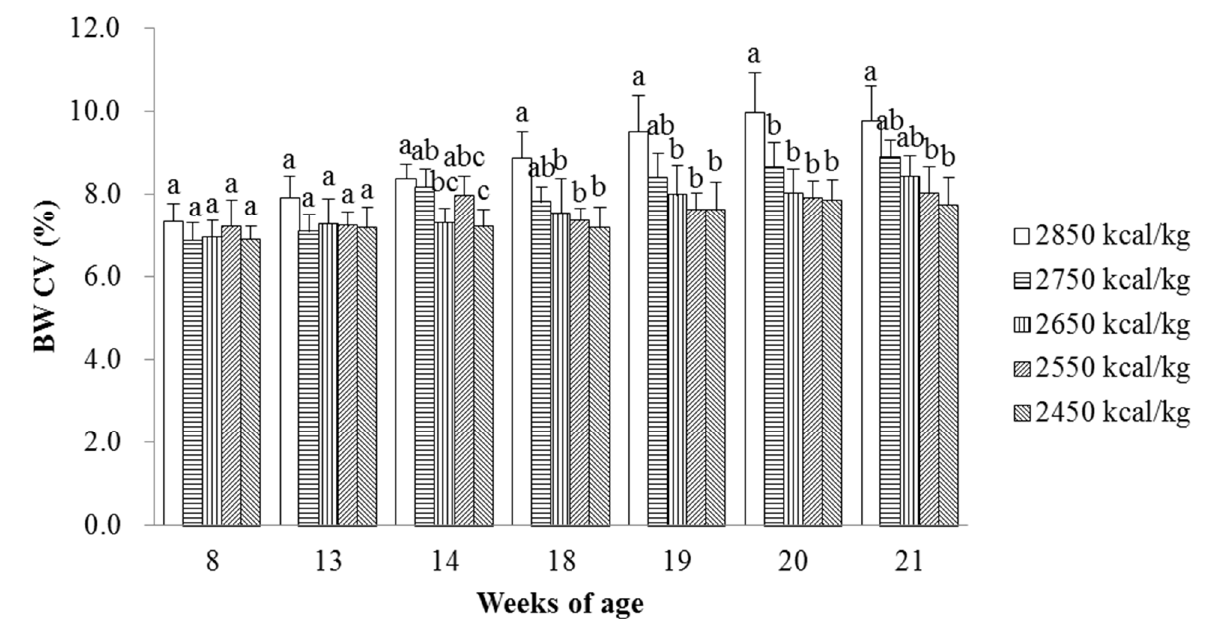
Figure 3. Effects of energy-restricted feeding and switching to ad libitum feeding on BW coefficient of variation (CV) of